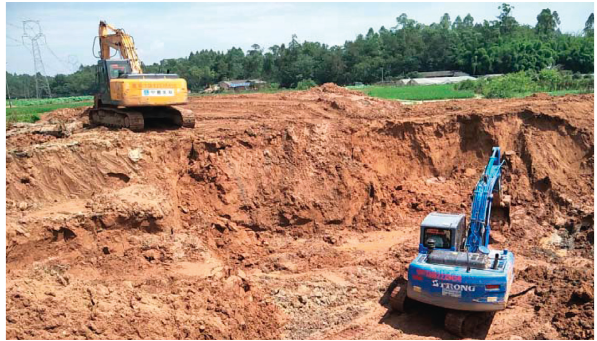
Figure 16: Landform of the engineering case. Table 9: Acting forces of the foundations.